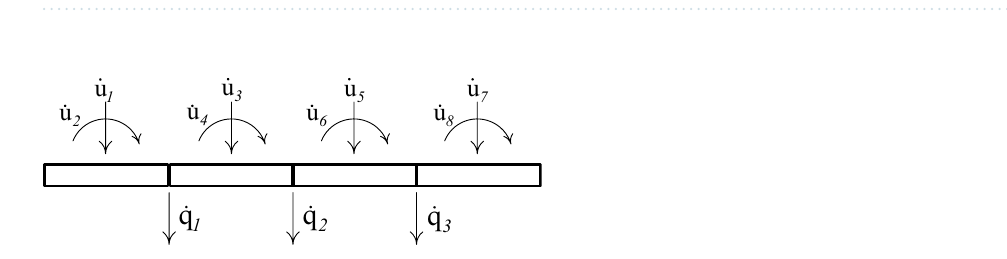
Figure 2. Lumped-mass system having centroidal velocities ˙ u related to inertia forces and independent nodal velocities ˙ q .